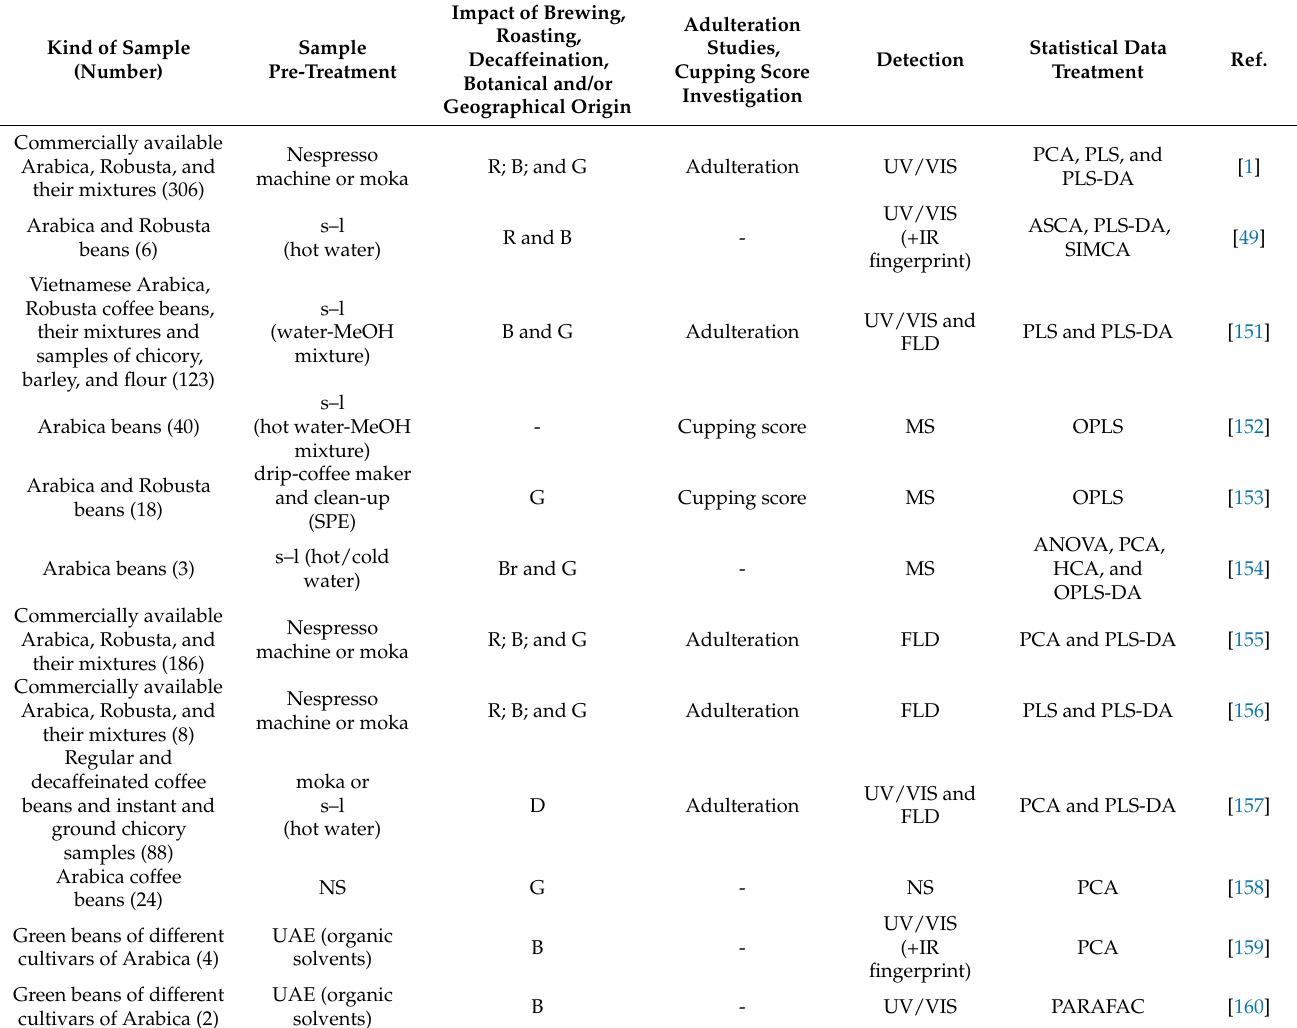
Table 2. Overview of non-targeted HPLC